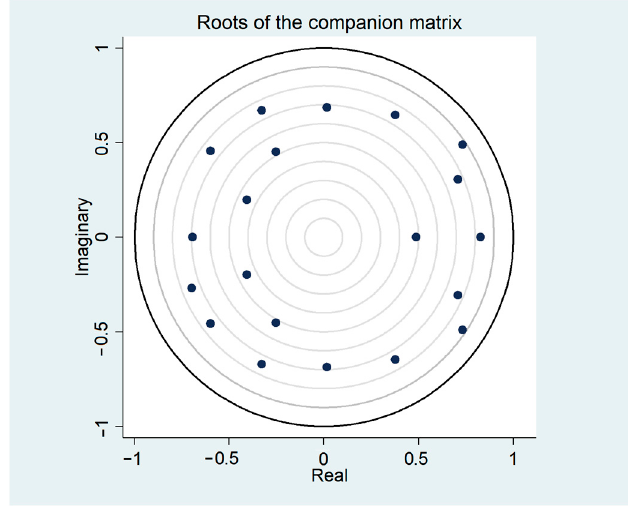
Figure 3. Model stability test result.